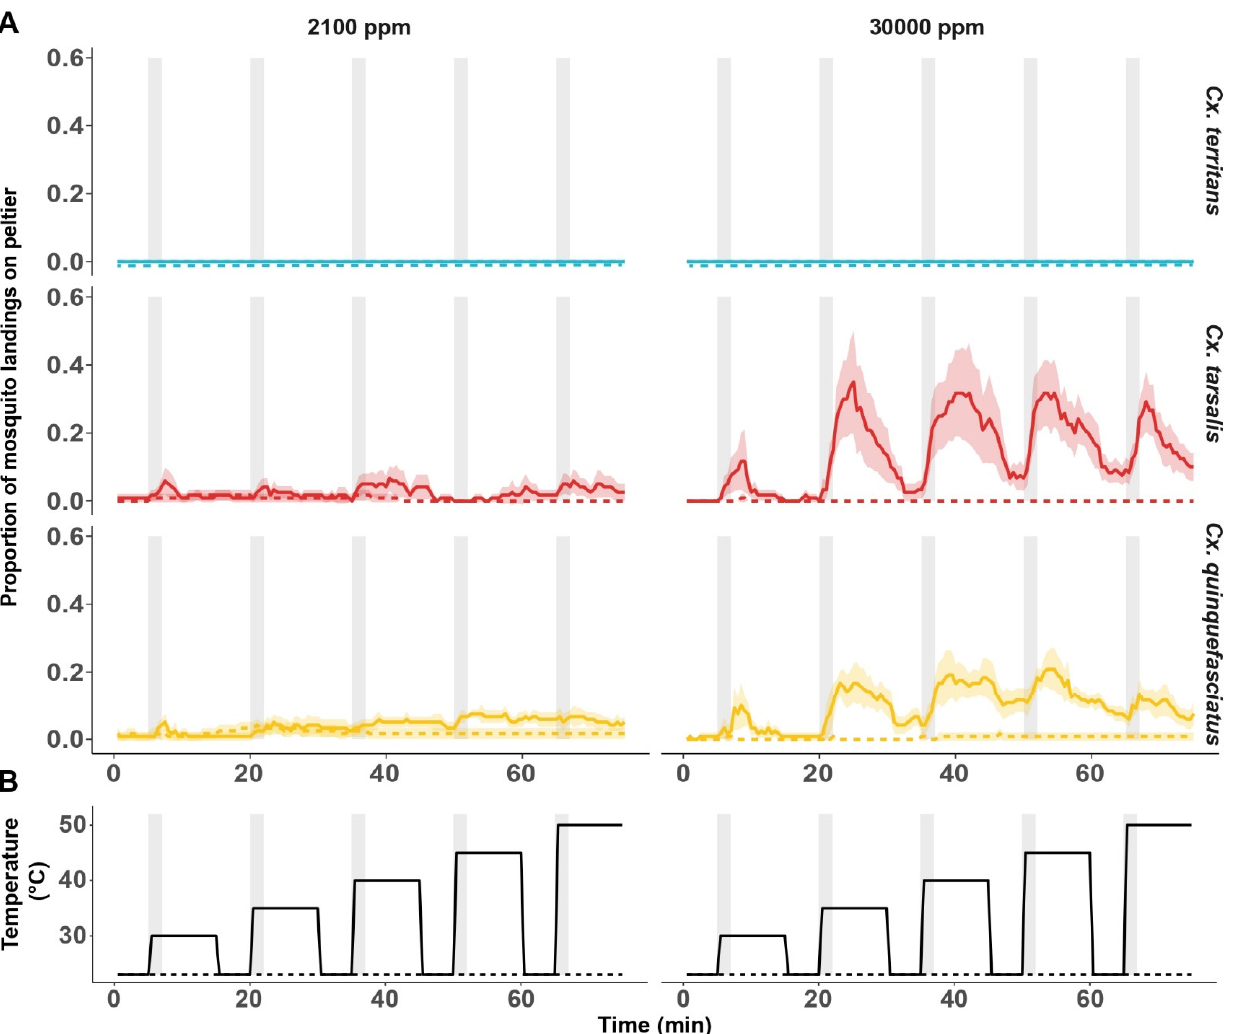
Figure 6. Heat seeking of Culex mosquitoes exposed to pulsed CO 2 at low or high concentrations. ( A ). Mean proportion of mosquito landings on the ambient (23 °C; dashed line) and warm (30–50 °C; solid line) Peltier elements in the presence and absence of CO 2 at concentrations of 2100 ppm (left) and 30,000 ppm (right). The shaded region around the mean denotes the 95% confidence interval. ( B ). Schematic representation of Peltier elements’ temperatures, both ambient (dashed line) and warm (solid line), as a function of time in the heat-seeking assay. Vertical gray bars denote the 2-min CO 2 pulses that accompanied the thermal stimuli in the assay. Eight replicates (n = 15) per condition per species have been used.